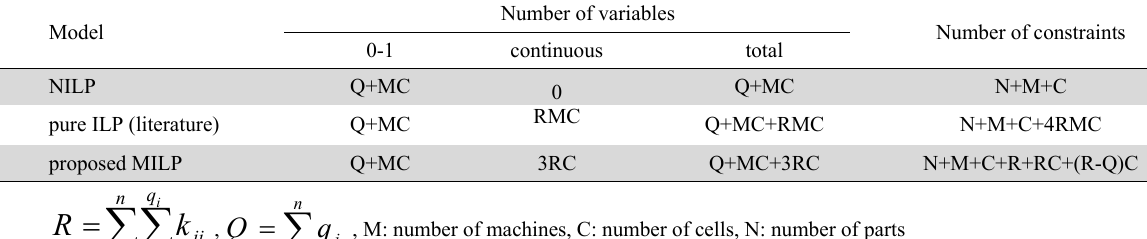
Comparison between proposed model and other existing models Model